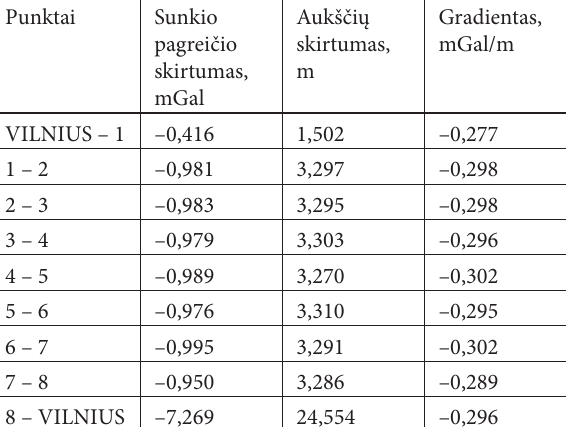
Table 4. The changes of the daily zero drift μgal